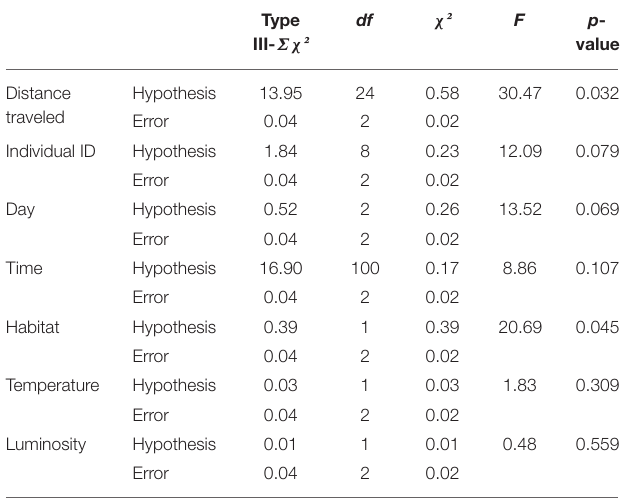
TABLE 1 | GLM to test the relationships between directionality and other factors collected during the tracking experiment to investigate the brumation behavior of Dryophytes japonicus